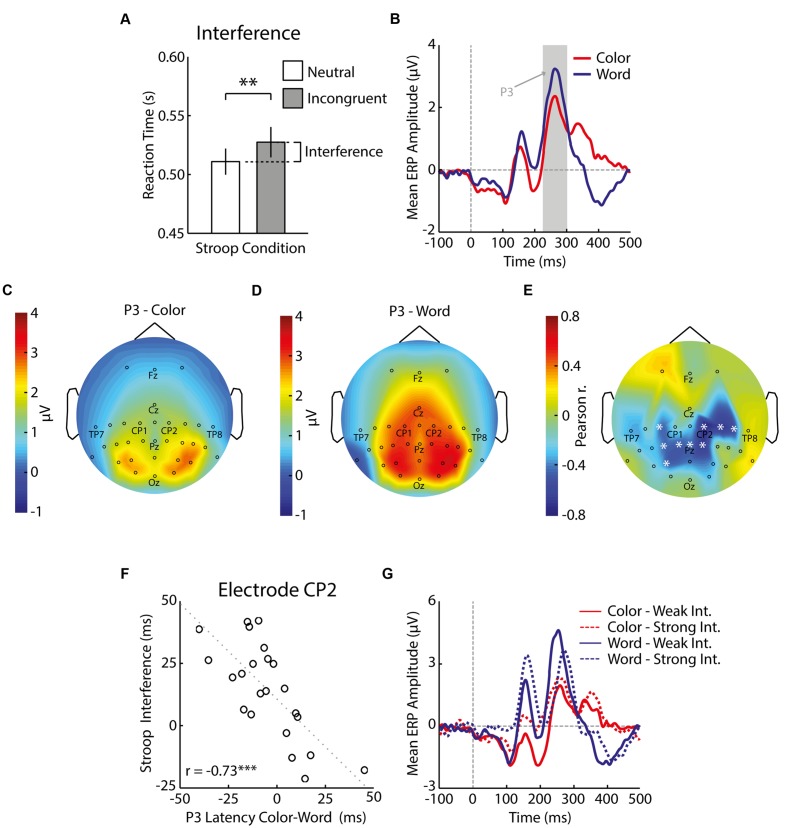
Behavioral and electrophysiological results of Experiment 1. The bar graph with mean and standard error of reaction times shows that incongruent trials induced significantly slower responses (∗∗p < 0.01) than neutral trials (A). Grand-average ERPs (i.e., average across all electrodes and subsequently across all participants) depict brain responses to colored rectangles (red) and colorless words (blue) presented in isolation (B). The gray patch shows the period of the P3 (250–300 ms) and the dashed vertical gray line indicates the time of stimulus presentation. Scalp distributions of the P3 to colors (C) and words (D) reflect the average EEG signal per electrode (data was averaged in the window specified above per participant and subsequently averaged across all participants). The relative P3 latency of colors minus words correlated with Stroop interference, especially over parietal and right central-parietal regions (E), and the correlation was highest at CP2 (F). Each electrode that is replaced by a white asterisk in (E) indicates a significant correlation (p < 0.05), and each circle in (F) indicates the average difference in reaction times between incongruent and neutral Stroop trials and average difference in P3 latency to color and word stimuli per participant (∗∗∗p < 0.001). The dotted line indicates a linear regression line fitted to the data. The negative correlations imply that participants whose word P3 peaked later relative to the color P3 showed stronger Stroop interference (G). The legend indicates ERPs to colors (red) and words (blue) for participants with either weak (solid lines) or strong (dashed lines) interference in the Stroop task, as determined by a median split.